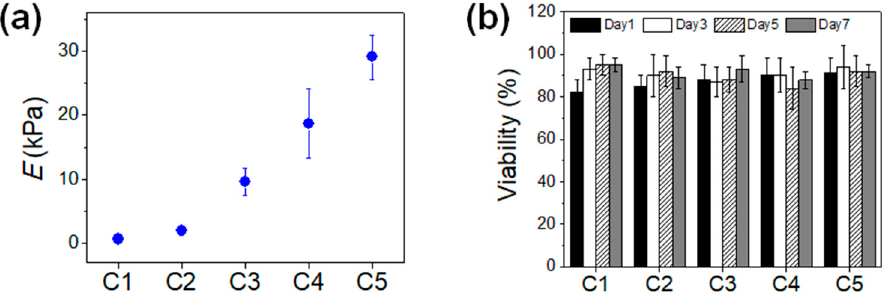
Figure 2. ( a ) Elastic moduli ( E ) of MGel hydrogels at varying concentrations; ( b ) The viability of MCF- cells encapsulated in microgels at varying MGel concentrations, measured at various times up to 7 days.